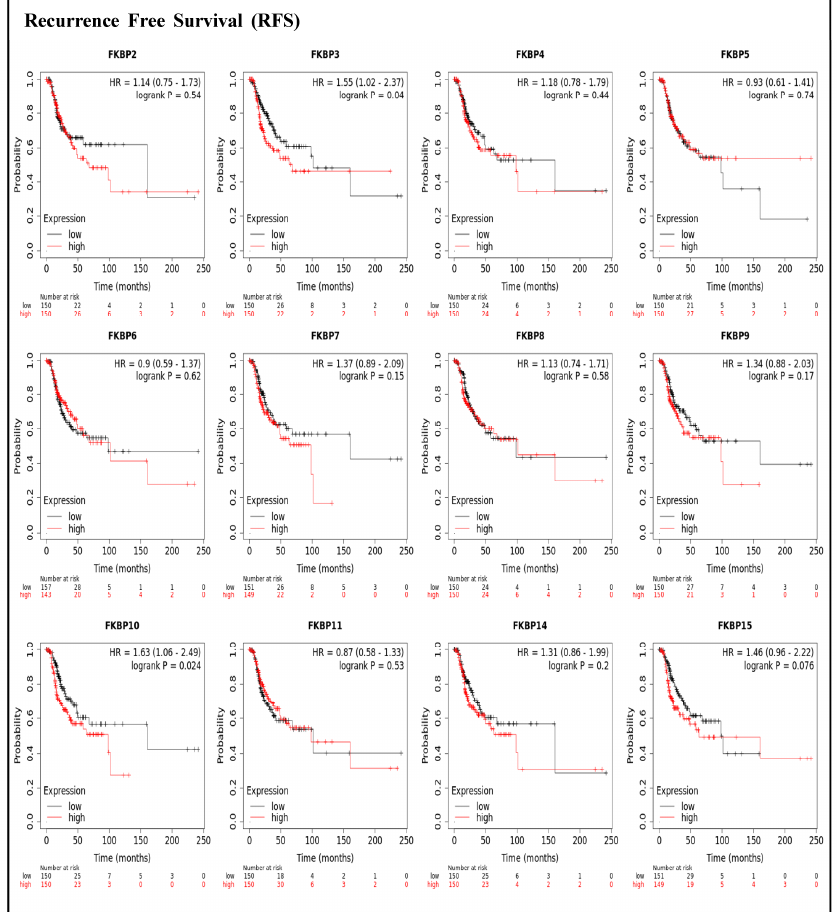
Figure 3. Prognoses of mRNA expression levels of FKBP gene family members in lung adenocarcinoma (LUAD) patients in terms of a relapse-free survival (RFS) analysis using the KM plotter database. Low expression levels of FKBP3 and FKBP10 were significantly related to greater RFS values. The setting for filtering LUAD patients was the median level.